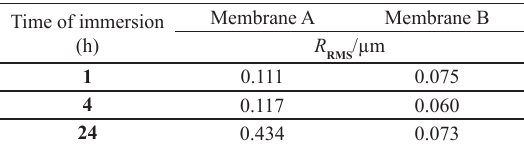
Table 1. Roughness calculated from the AFM images of the membranes A and B .